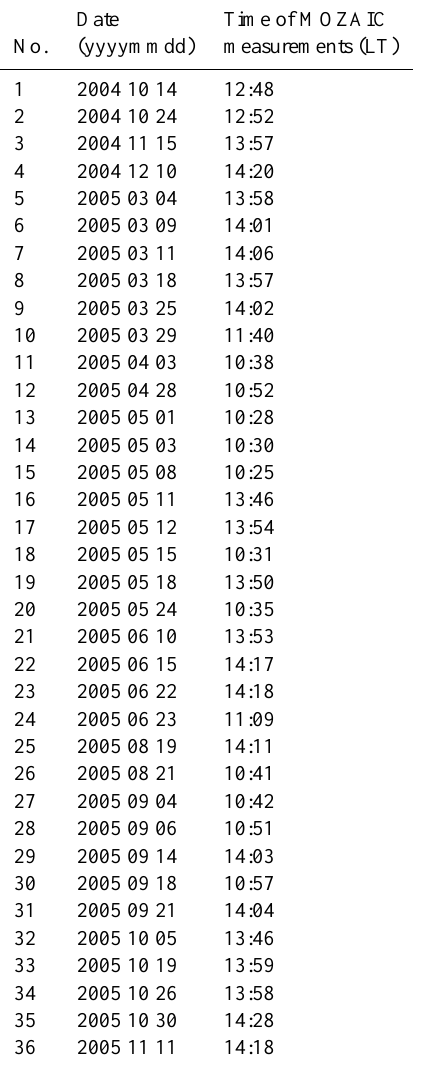
Table 1. List of the data used for comparison of MOZAIC and OMI.